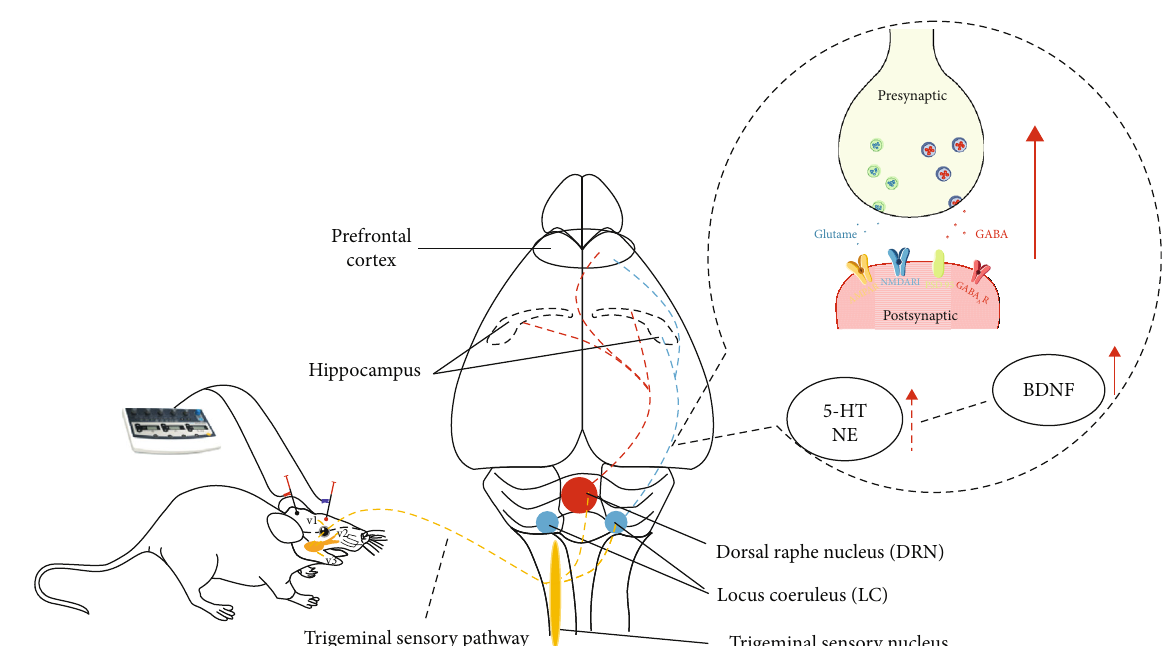
Figure 10: Schematic chart of the possible pathway for EA at GV20 and EX-HN3 against poststroke cognitive impairment in a rat